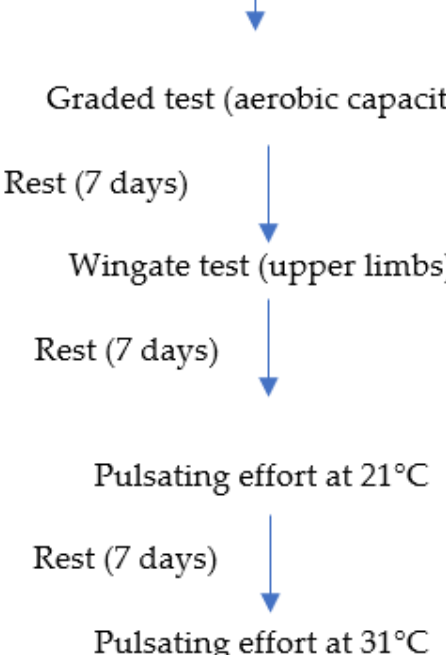
Figure 1. Study design.